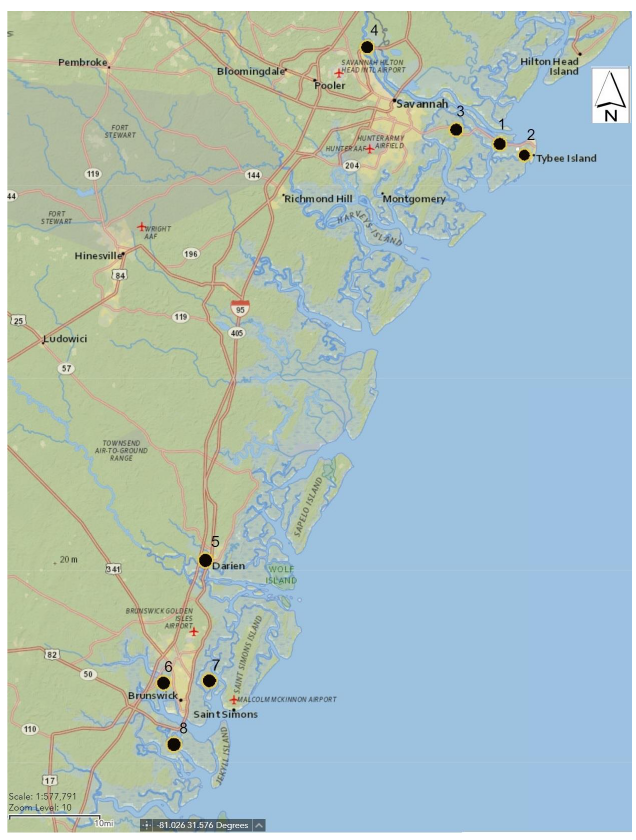
Figure 1. Salt marshes along the coast by Georgia (USA), selected to evaluate vegetation and interstitial soil